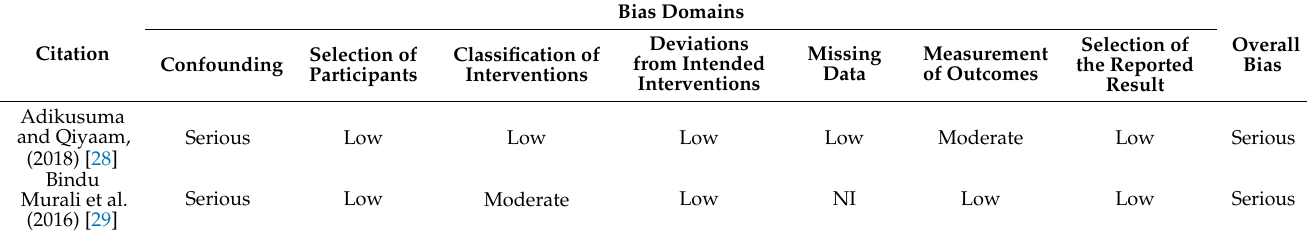
Table 3. Risk of bias in non-randomized trials